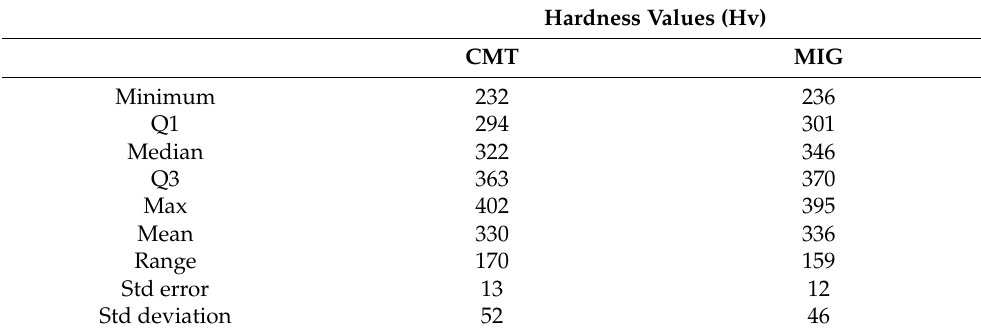
Table 3. Hardness value distribution analysis of CMT and MIG across parameter range.